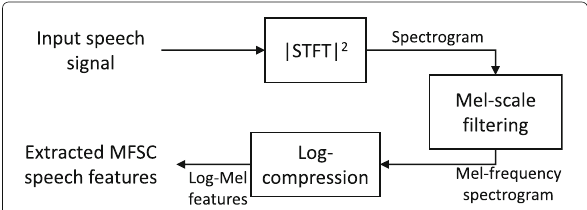
Fig. 2 Stages of MFSC feature extraction used as input to the DS-CNN classifier. A spectrogram was computed based on the audio signal. From the spectrogram, a mel-frequency spectrogram with log-compression was derived to produce MFSC